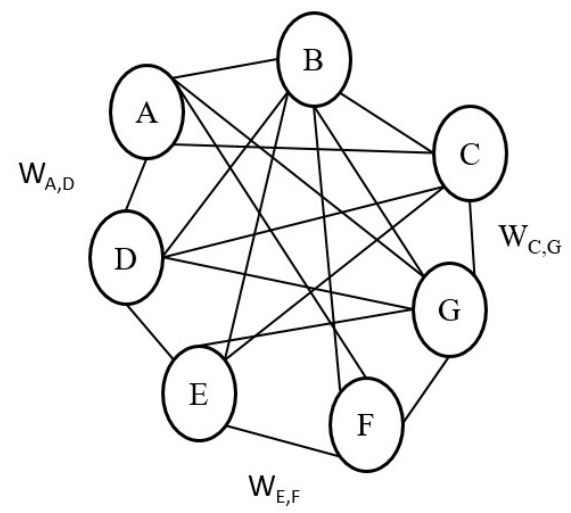
Figure 5. Boltzmann